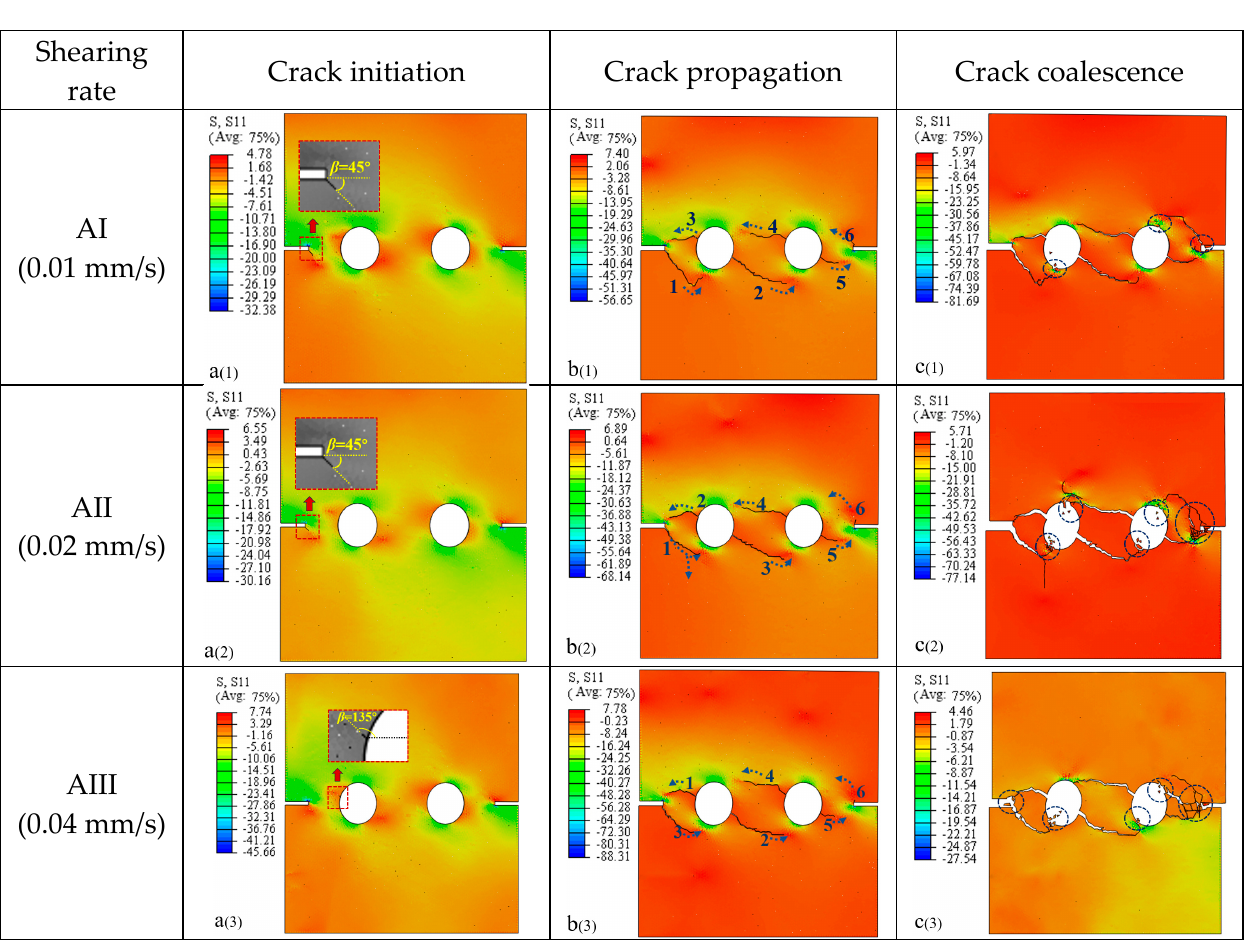
Figure 11. Stress distribution and crack propagation process of rock-like materials at different shear rates. a(1)–a(3). The stage of crack initiation; b(1)–b(3). The stage of crack propagation; c(1)–c(3). The stage of crack coalescence.